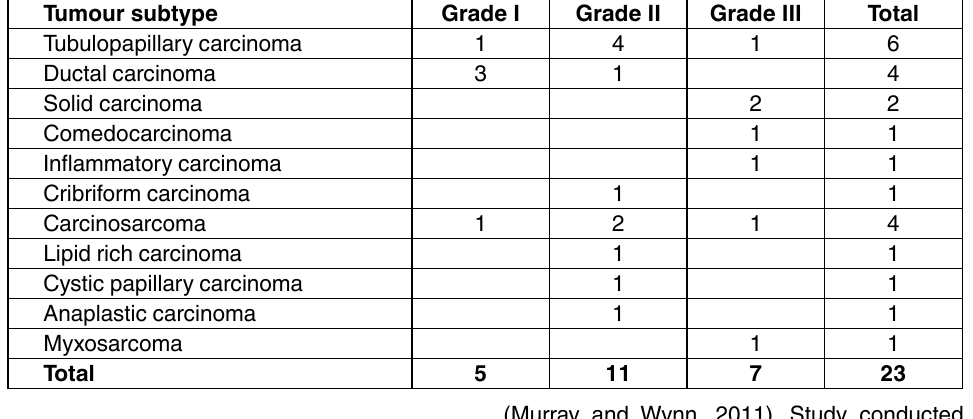
table 2. Histopathological subtypes and